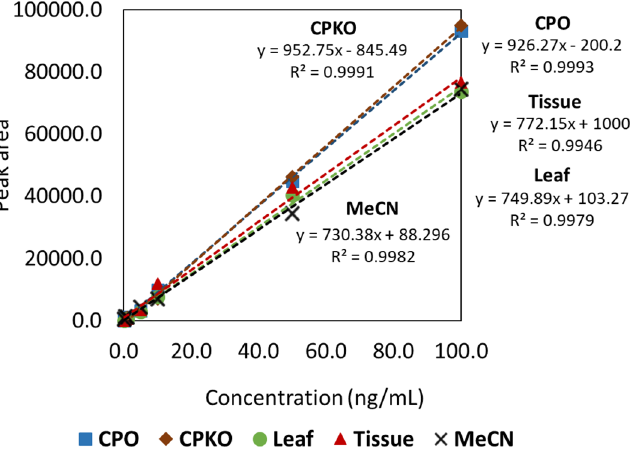
Figure 1. Solvent (MeCN) calibration curve and matrix-matched calibration curve in CPO, CPKO, leaf, and